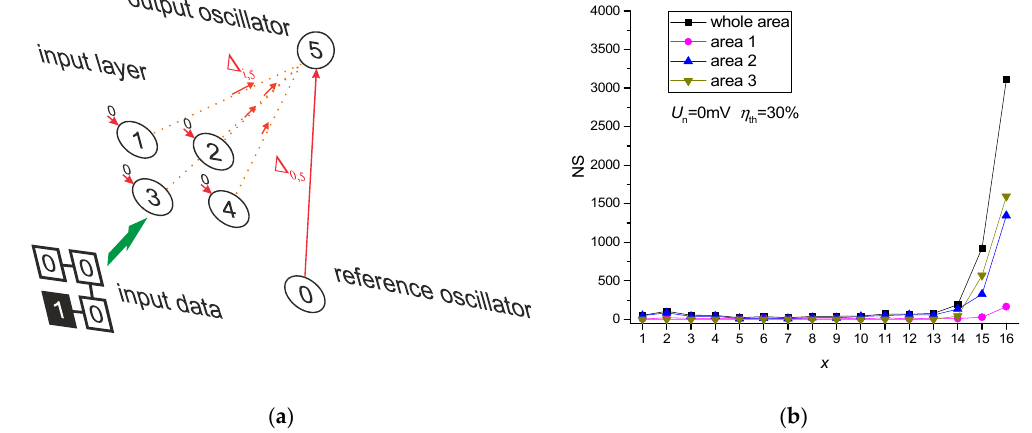
Figure 18. ( a ) Model scheme of ONN containing only unidirectional couplings of oscillator No.0–4 with output oscillator No.5, and ( b ) distribution of the number of NS solutions to the “ x of x ” problem.